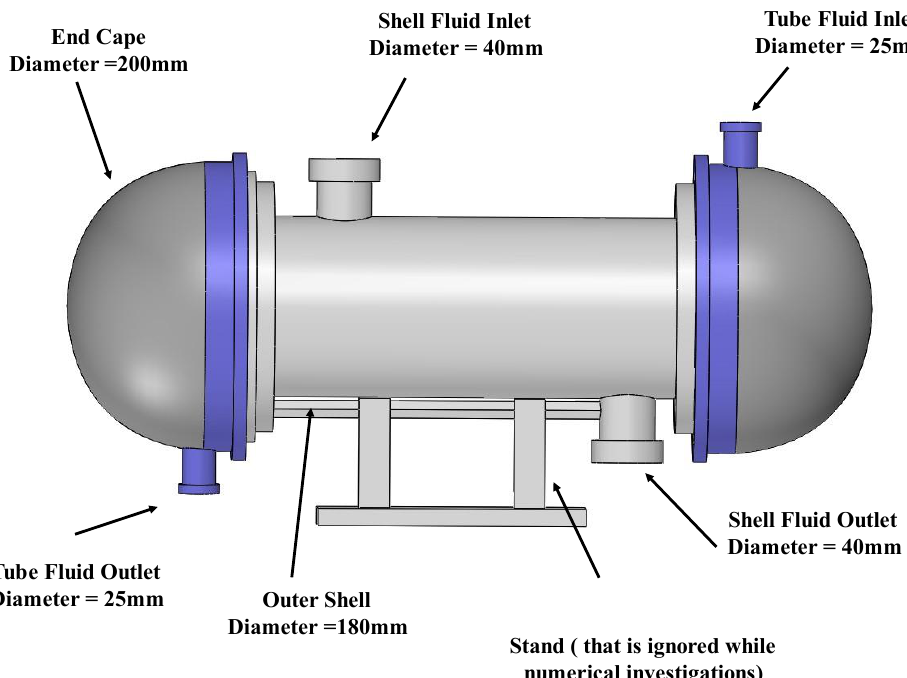
Figure 1. CAD Design of the Shell and Tube Heat Exchanger.